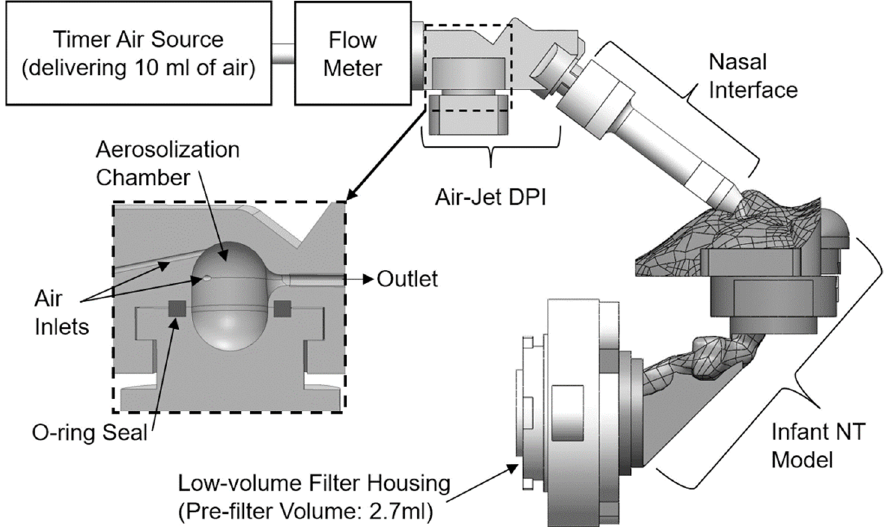
Figure 8. In vitro preterm infant nose throat (NT) model for evaluation of a novel in-line DPI. The inset shows an expanded view of the air-jet DPI, illustrating internal components, including the aerosolization chamber. NT, nose-throat [35].